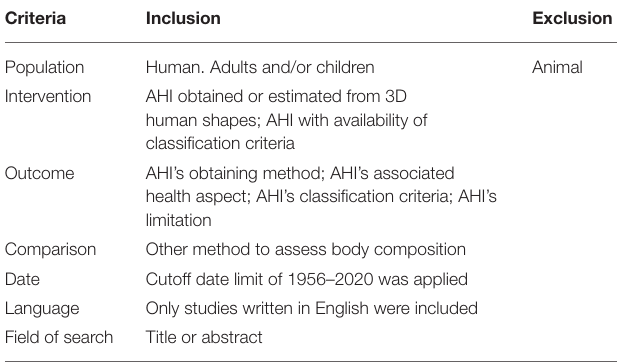
TABLE 1 | List of AHIs grouped into the four categories. TABLE 2 | Inclusion and exclusion criteria according to